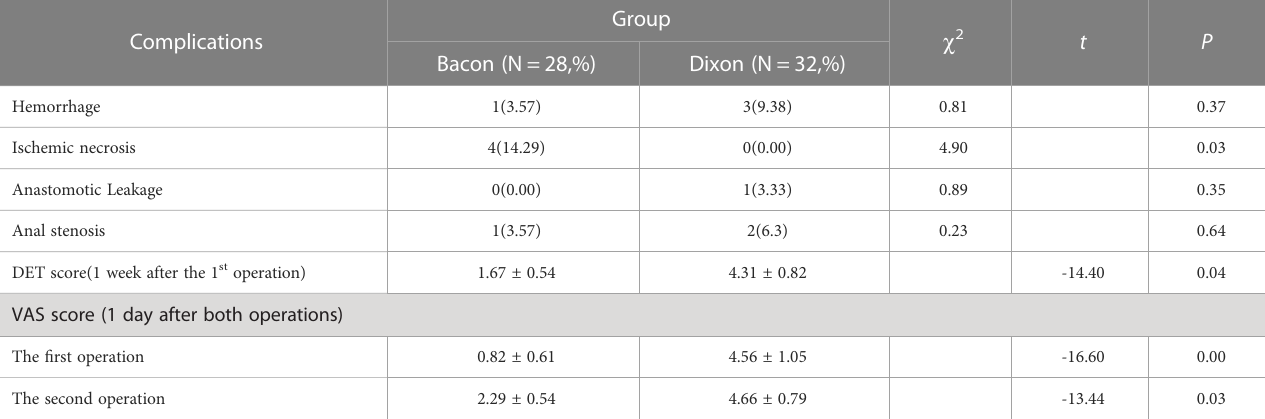
TABLE 3 Comparison of postoperative complications.